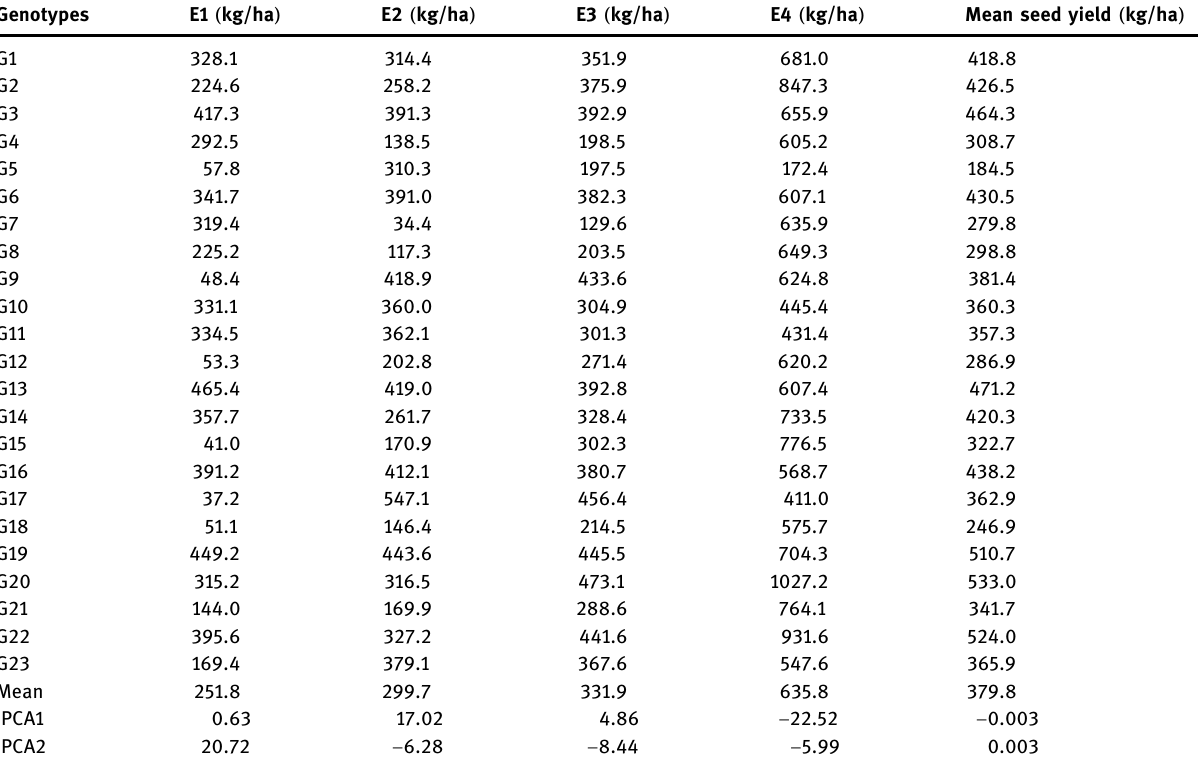
Table 4: Mean yield of AYB tested across the four - year environments